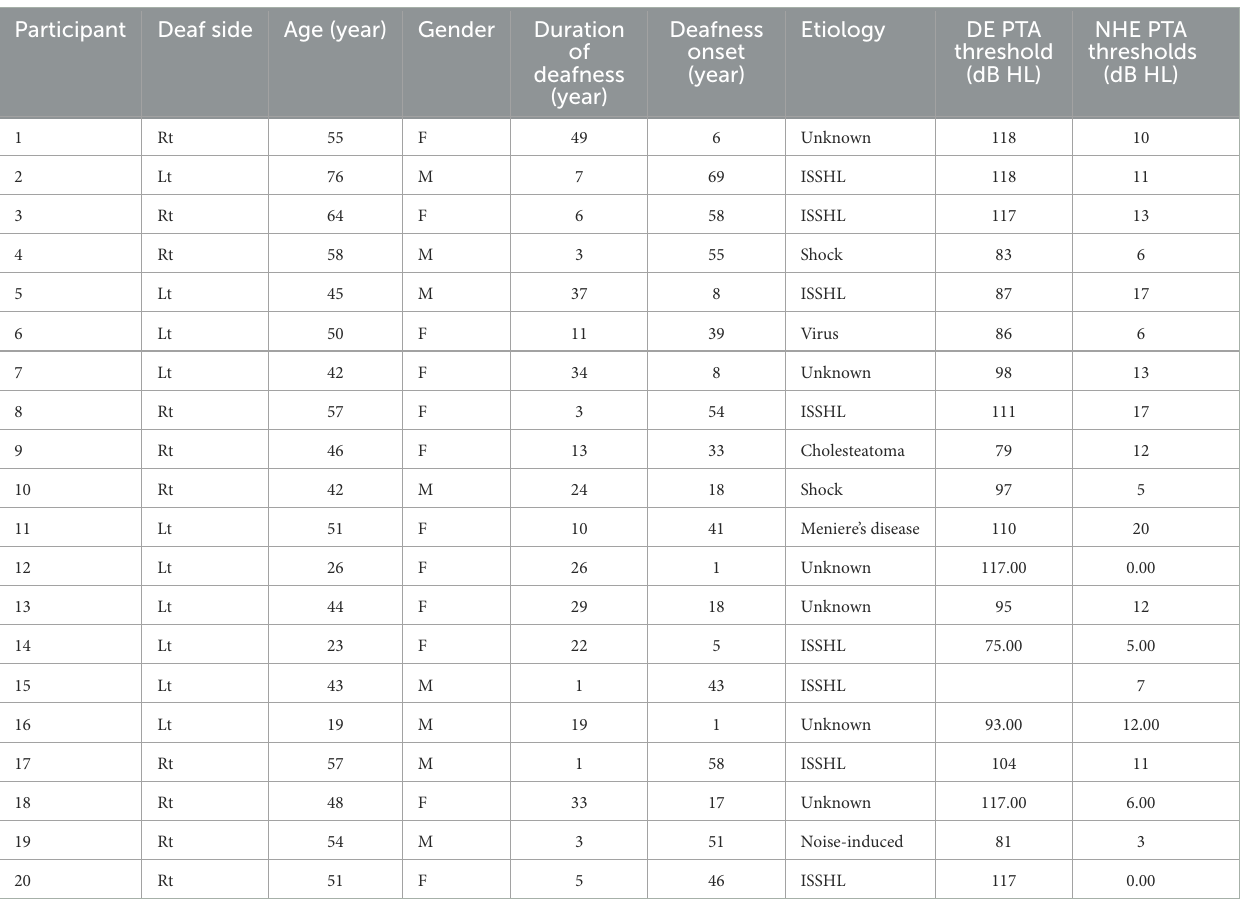
TABLE 1 Clinical features of participants with single-sided